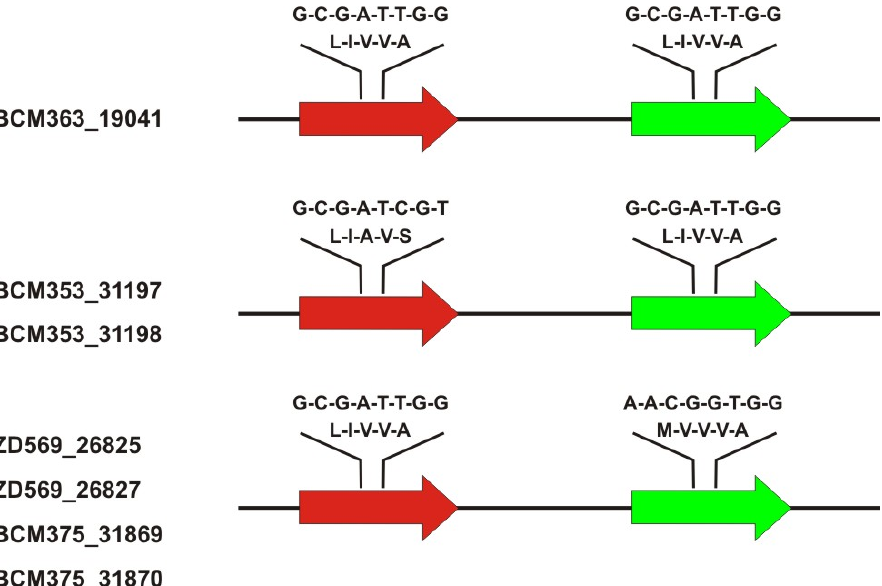
Figure 1. OPN1LW and OPN1MW exon 3 genotypes in the study group. Overview of the OPN1LW/OPN1MW gene cluster composition and exon 3 haplotypes in the investigated patients. Exon 3 haplotypes are depicted at the nucleotide sequence level (cDNA sequence positions: c.453-c.457-c.465-c.511-c.513-c.521-c.532-c.538) and the corresponding amino acid residues (at positions p.153-p.171-p.174-p.178-p.180).